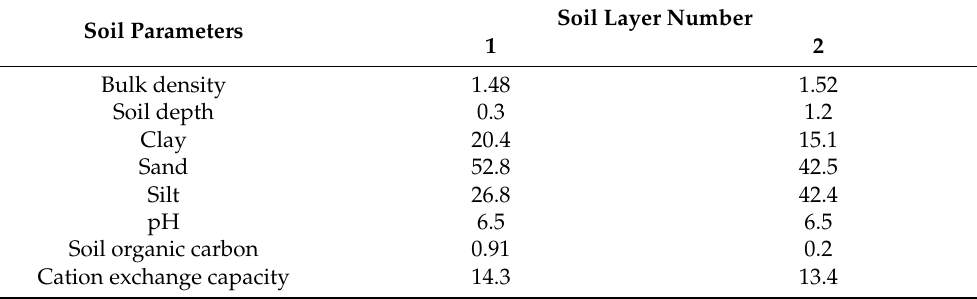
Table A1. Representative soil characteristics of the Cradock Research Farm used as inputs into the Environmental Policy Integrated Climate (EPIC) model (obtained from [32]). Clay, sand, silt, soil organic carbon units are in percentages, whereas bulk density, soil organic carbon and ion exchange capacity are in g cm − 3 m and (cmol (+) kg − 1 ),